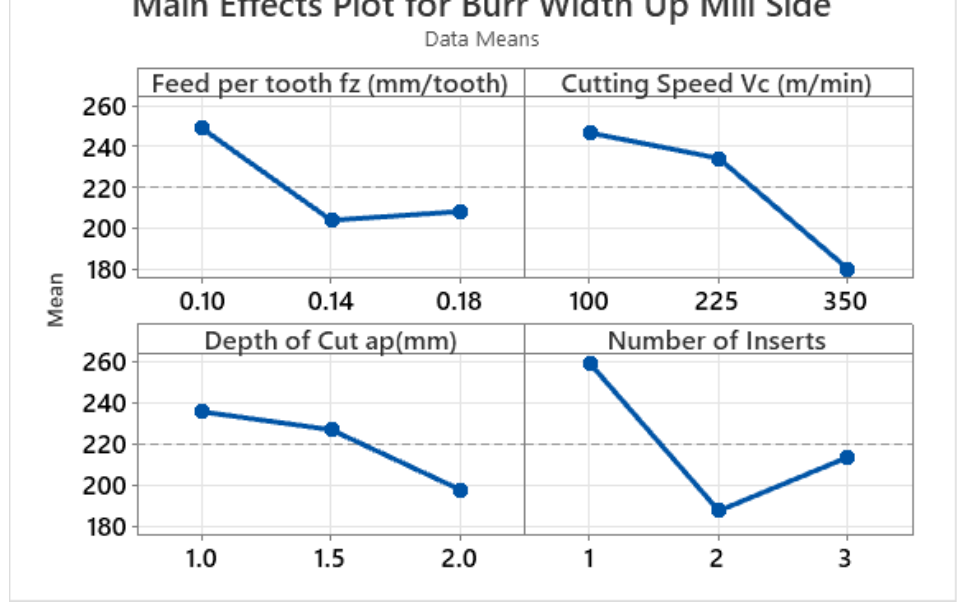
Figure 4. Main effect plots for burr width on up-milling side (µm).